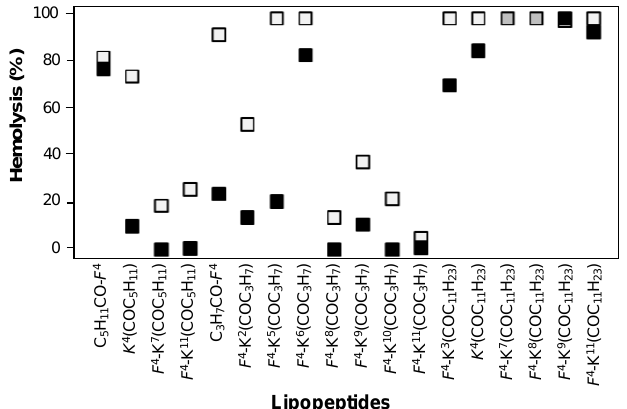
Figure 5. Hemolytic activity of the lipopeptides incorporating all L -amino acids or a D -amino acid. The x axis includes the code for each lipopeptide. The residue that can be an L - or a D -amino acid is indicated in italics. Hemolytic activity was measured at 250 µM and is expressed as a percentage compared to melittin as a standard. Black squares correspond to the hemolysis of lipopeptides with a D -amino acid, white squares to the hemolysis of lipopeptides with all L-amino acids, and grey squares indicate that both lipopeptides display the same hemolysis. Data can be found in Table S2 (Supplementary Materials).